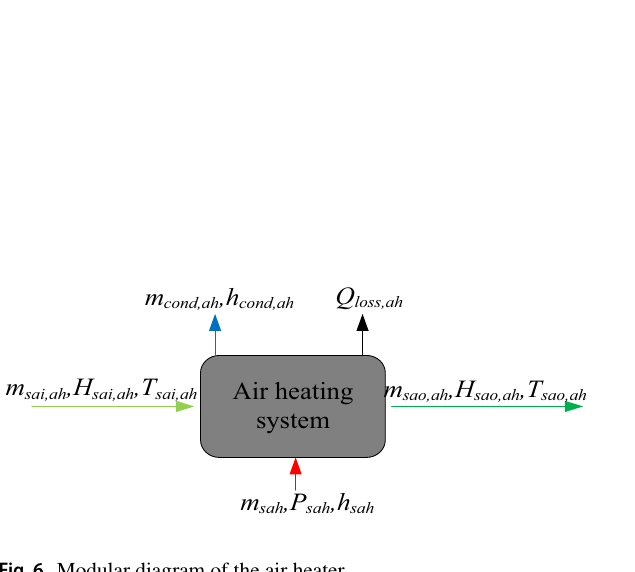
Fig. 6 Modular diagram of the air